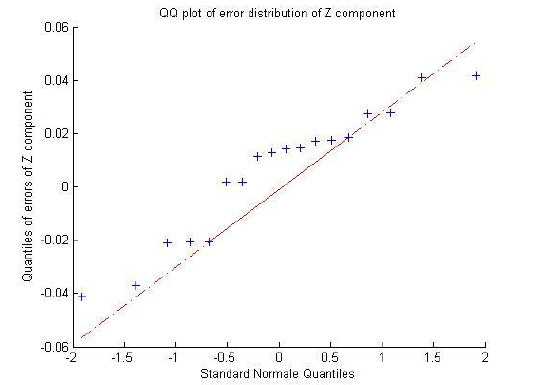
Figure 7. Q-Q plot for the distribution of ΔZ Also the Q-Q plots for X (Figure 8) and Y (Figure 9) coordinates show some deviations from the normal distribution.